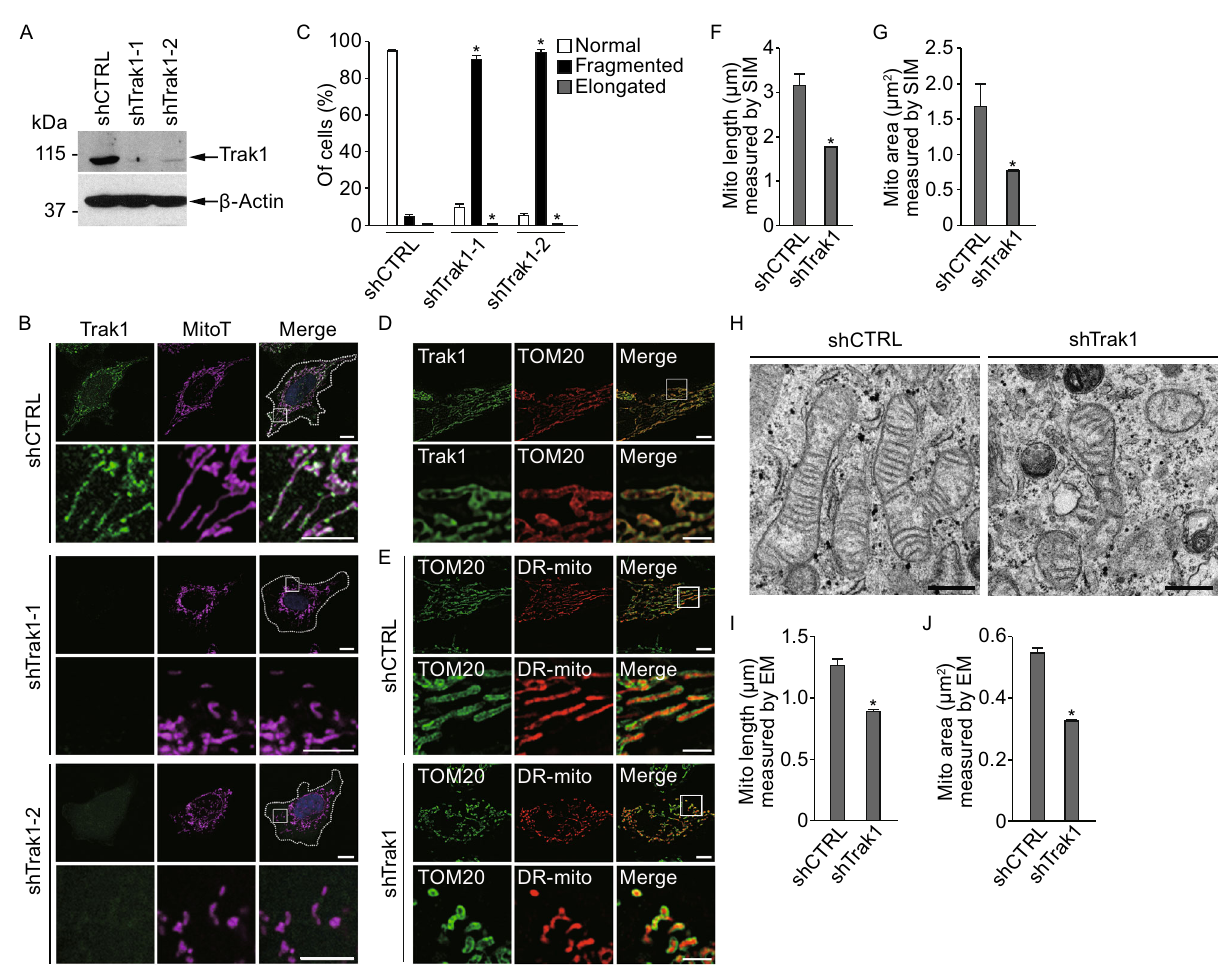
Figure 1. Depletion of endogenous Trak1 alters mitochondrial morphology. (A) Western blot analysis of cell lysates with anti- Trak1 antibody shows depletion of endogenous Trak1 protein in HeLa cells stably transfected with Trak1-targeting shRNAs (shTrak1- 1 and shTrak1-2) compared with HeLa cells transfected with non-targeting control shRNAs (shCTRL). Anti- β -actin immunoblotting was used as a loading control. (B) Immuno fl uorescence confocal microscopic analysis with anti-Trak1 antibody (green) and MitoTracker Deep Red (MitoT; purple) shows altered mitochondrial morphology in shTrak1-transfected HeLa cells compared with the shCTRL-transfected control. The boundary of cells is indicated by the dotted line and the nuclei are visualized by DAPI stain (blue) in merged images. Enlarged view of the boxed region is shown below the original image. Scale bars: 10 μ m in the original images and 5 μ m in the enlarged images. (C) The percentage of cells with indicated mitochondrial morphology was quanti fi ed and shown as mean ± SEM of three independent experiments. *, P < 0.05 versus the shCTRL-transfected control, one-way analysis of variance with a Tukey ’ s post hoc test. (D – G) Dual-color 3D-SIM super-resolution imaging analysis of HeLa cells (D) immunostained with anti-Trak1 antibody (green) and anti-TOM20 antibody (red); and shCTRL- or shTrak1-transfected HeLa cells (E) labeled with DsRed2-mito (DR- mito; red) and anti-TOM20 antibody (green). Enlarged view of the boxed region is shown below the original image. Scale bars: 5 μ m in the original images and 2 μ m in the enlarged images. Mitochondrial length (F) and mitochondrial area (G) were quanti fi ed and shown as mean ± SEM of three independent experiments. In total, 382 (shCTRL) and 516 (shTrak1) mitochondria were analyzed. *, P < 0.05 versus the shCTRL control, unpaired two-tailed Student ’ s t test. (H – J) Electron microscopic analysis of mitochondrial ultrastructure in shCTRL- or shTrak1-transfected HeLa cells (H). Scale bars: 0.5 μ m. Mitochondrial length (I) and mitochondrial area (J) were quanti fi ed and shown as mean ± SEM ( n = 5). In total, 84 (shCTRL) and 115 (shTrak1) mitochondria were analyzed. *, P < 0.05 versus the shCTRL control, unpaired two-tailed Student ’ s t